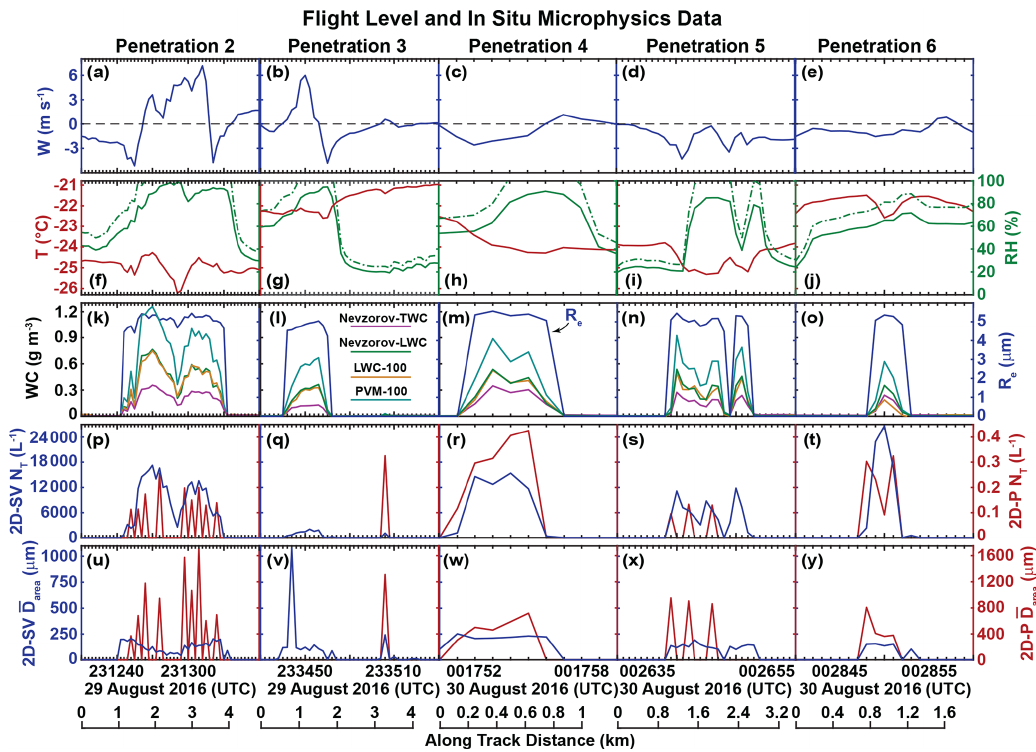
Figure 14. UWKA flight-level and in situ microphysics data for penetrations 2–6 (Fig. 1d, Table 2). (a–e) Vertical air velocity (blue), (f–j) temperature (red), relative humidity with respect to liquid (solid green) and relative humidity with respect to ice (dashed green), (k–o) bulk water content (WC) from the Nevzorov TWC probe (magenta), Nevzorov LWC probe (green), LWC-100 probe (gold), and PVM-100 probe (cyan), and cloud-droplet effective radii ( R e ) from the PVM-100 probe (blue), (p–t) total concentration ( N T ) from the 2D-SV probe (blue) and 2D-P probe (red), and (u–y) area-weighted mean diameter ( D area ) from the 2D-SV probe (blue) and 2D-P probe (red). Along-track distance for each penetration shown at bottom.